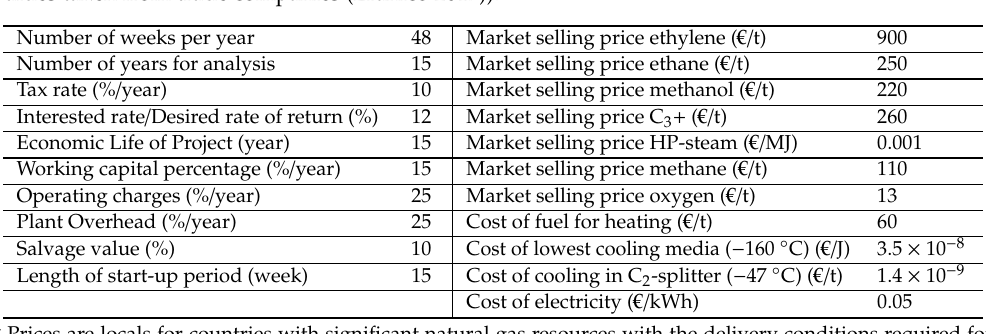
Table 4. Basic data for the techno-economic analysis: (left) operating and economic data; (Right) cost of the raw materials, utilities, and products* (The costs and selling prices are the average local market values taken from trade companies (Eranico